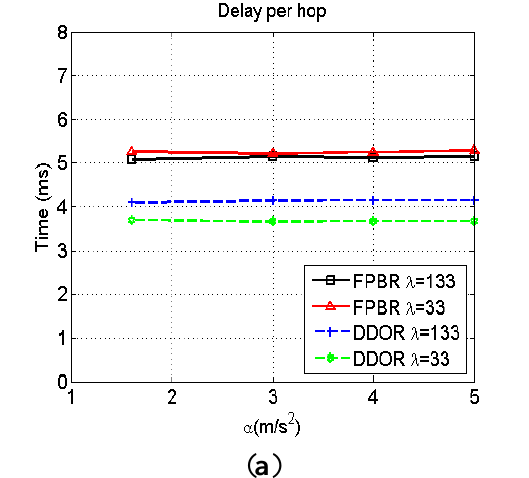
Figure 8. Delay per hop and end-to-end delay (EED) obtained with FPBR and DDOR when increasing the maximum acceleration, . Two different vehicle densities were considered for these plots: λ = 133 and λ = 33. ( a ) Delay per hop vs. α . ( b ) EED vs. α